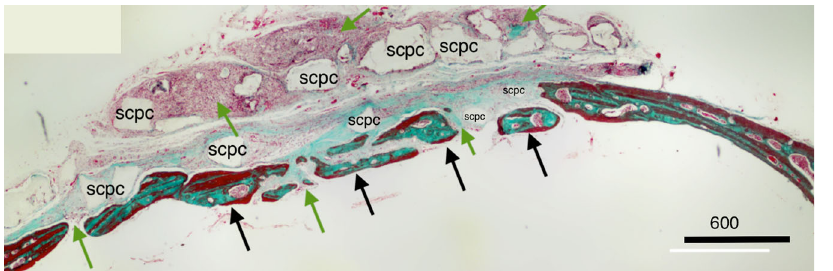
Fig. 3 Photomicrographs showing decalci fi ed histological sections of Group 1 (DSM/SCPC/hBMSC) stained with Masson trichrome. The sections show the whole cranial defect area with formation of new